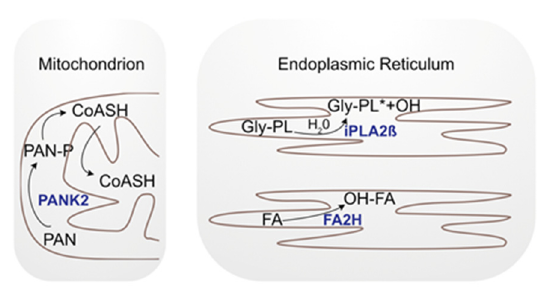
Figure 3. Simplified scheme of the cellular localization of NBIA genes. PANK2 is localized in the mitochondria where it phosphorylates pantothenate (PAN), a precursor of a Coenzyme A group (CoASH). FA2H and iPLA2-VIA are localized in the ER. Fatty acid hydroxylase (FA2H) adds a hydroxyl group (OH) to fatty acids (FA) and iPLA2ß hydrolyzes phospholipids (Gly-PL: glycerophospholipids; *: hydrolyzed).